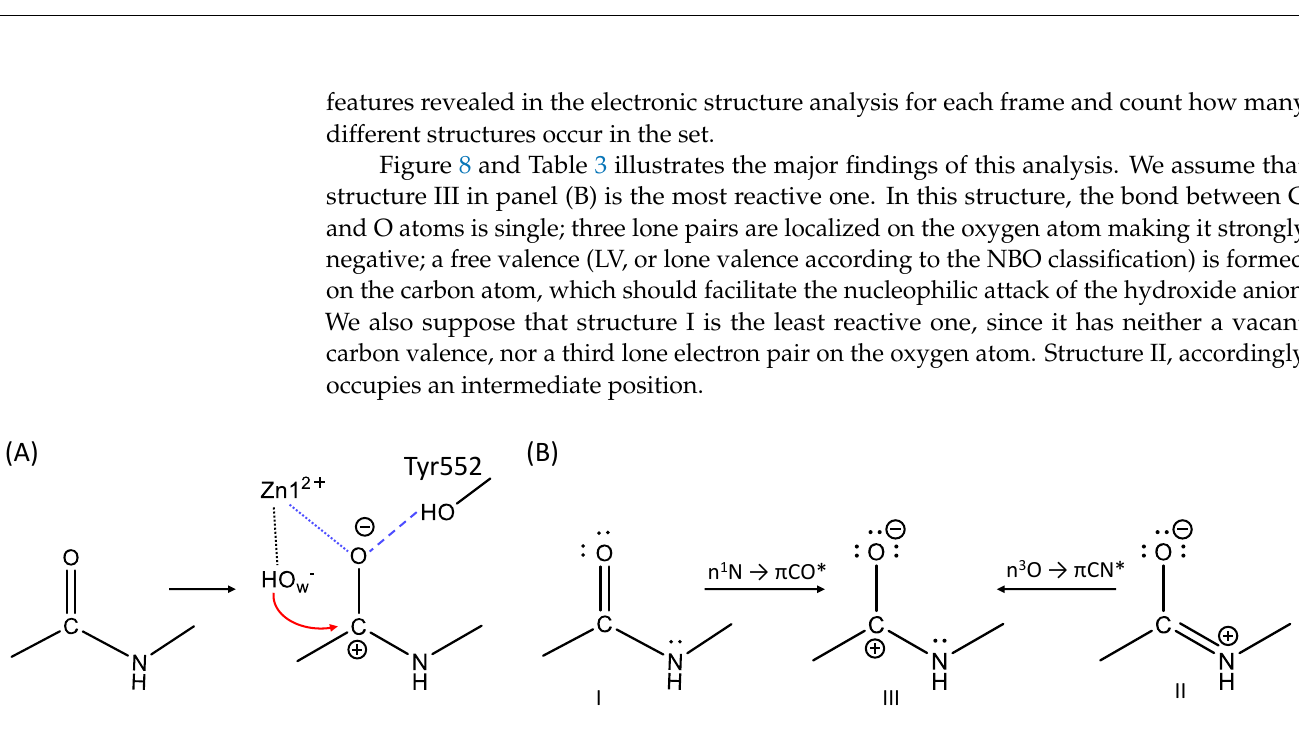
Figure 8. ( A ) The substrate activation in the active site of the enzyme. Dotted lines indicate the coordination bonds and the dashed line indicates a hydrogen bond. Blue lines show the interaction between the substrate and the “oxyanion hole”; the red arrow shows a direction of the nucleophilic attack. ( B ) Structures found by the NBO analysis of the ES complexes.